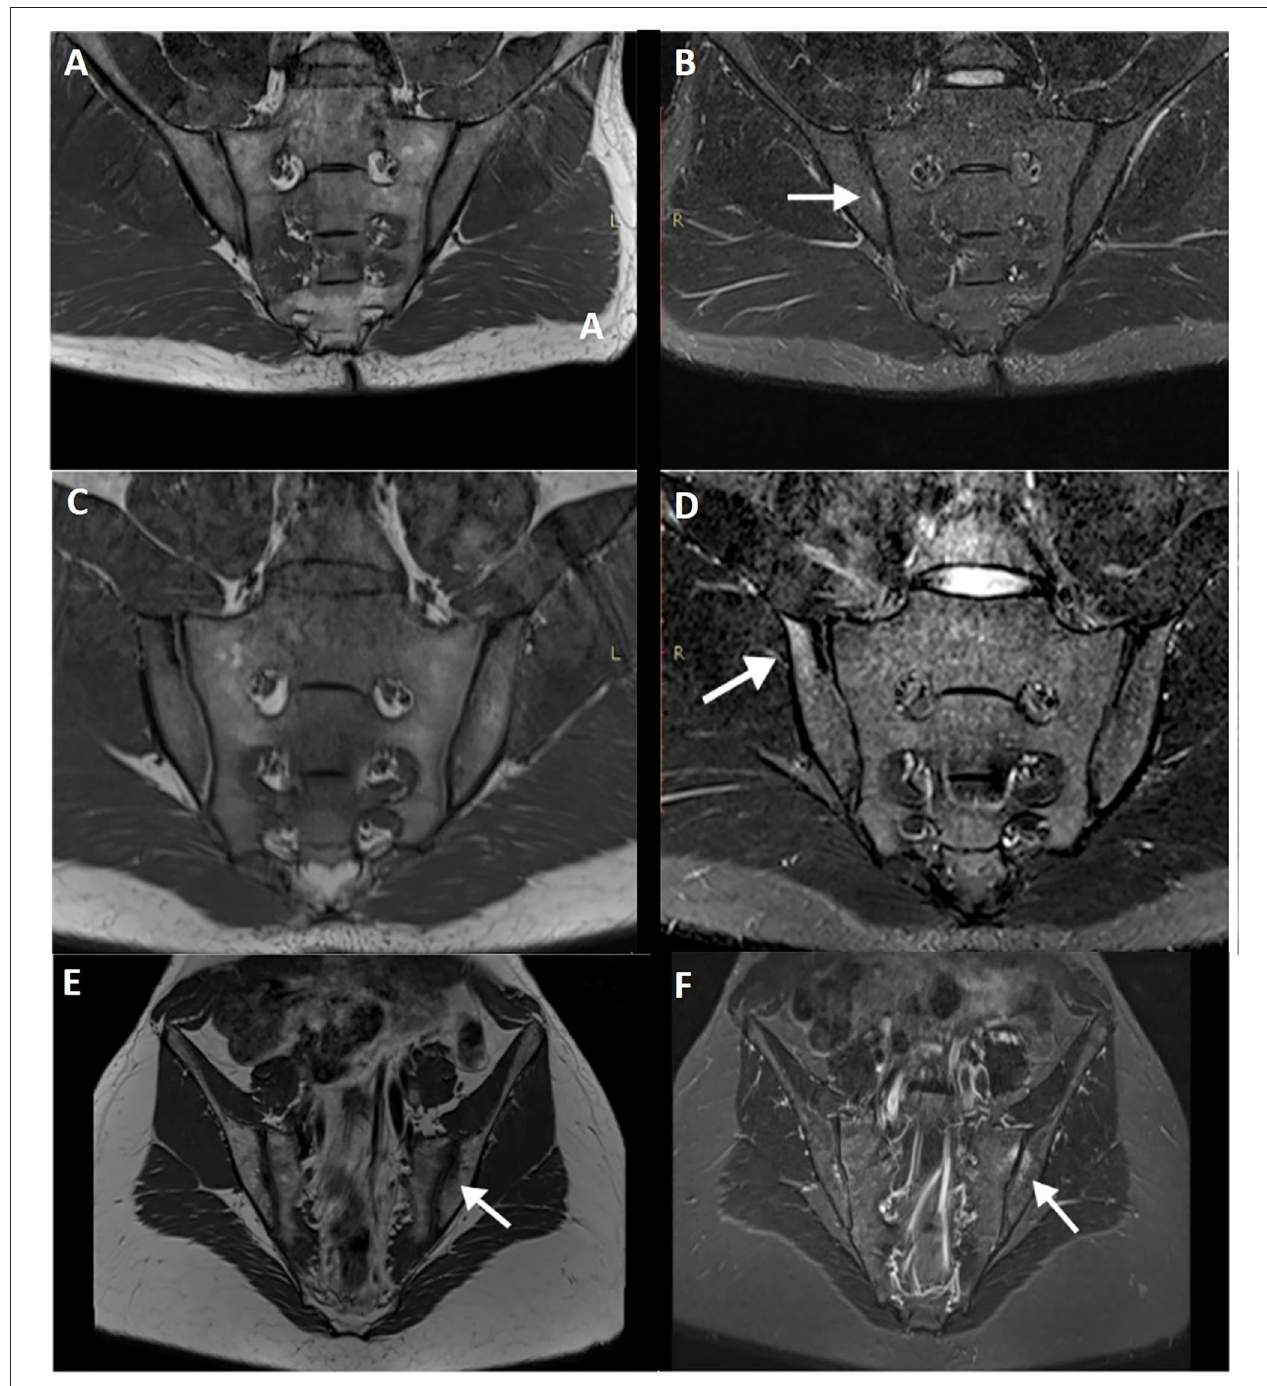
FIGURE 2 | T1WI (A) and STIR image (B) of a military subject showing a small, peri-articular, area of bone edema (arrow) on the iliac side of the right sacroiliac joint. T1WI (C,E) and STIR (D,F) images of a post-partum female with bilateral foci of bone edema (arrows) adjacent to the sacroiliac joint.